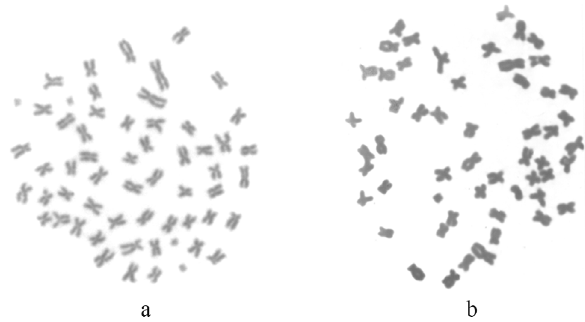
Figure 2 - Metaphases of (a) P. lineatus, with four supernumerary chro- mosomes (arrows). Supernumerary chromosomes occurred in all individ- uals of this species; (b) metaphase of P. nigricans with only one supernu- merary chromosome